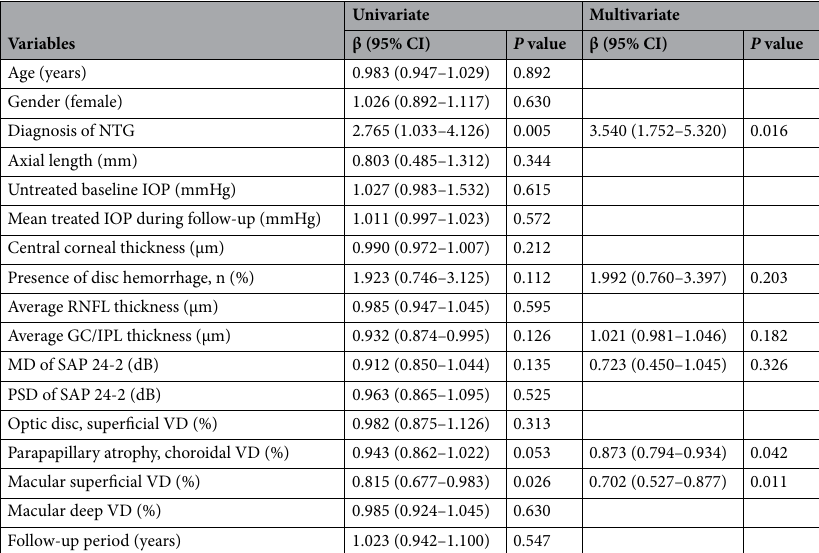
Table 2. Associated risk factors to 24-2 VF progression in glaucoma patients. Variables with P < 0.2 were entered in the multivariate analysis. NTG, normal-tension glaucoma; IOP, intraocular pressure; RNFL, retinal nerve fiber layer; GC/IPL, ganglion cell/inner plexiform layer; MD, mean deviation; PSD, pattern standard deviation; VD, vessel